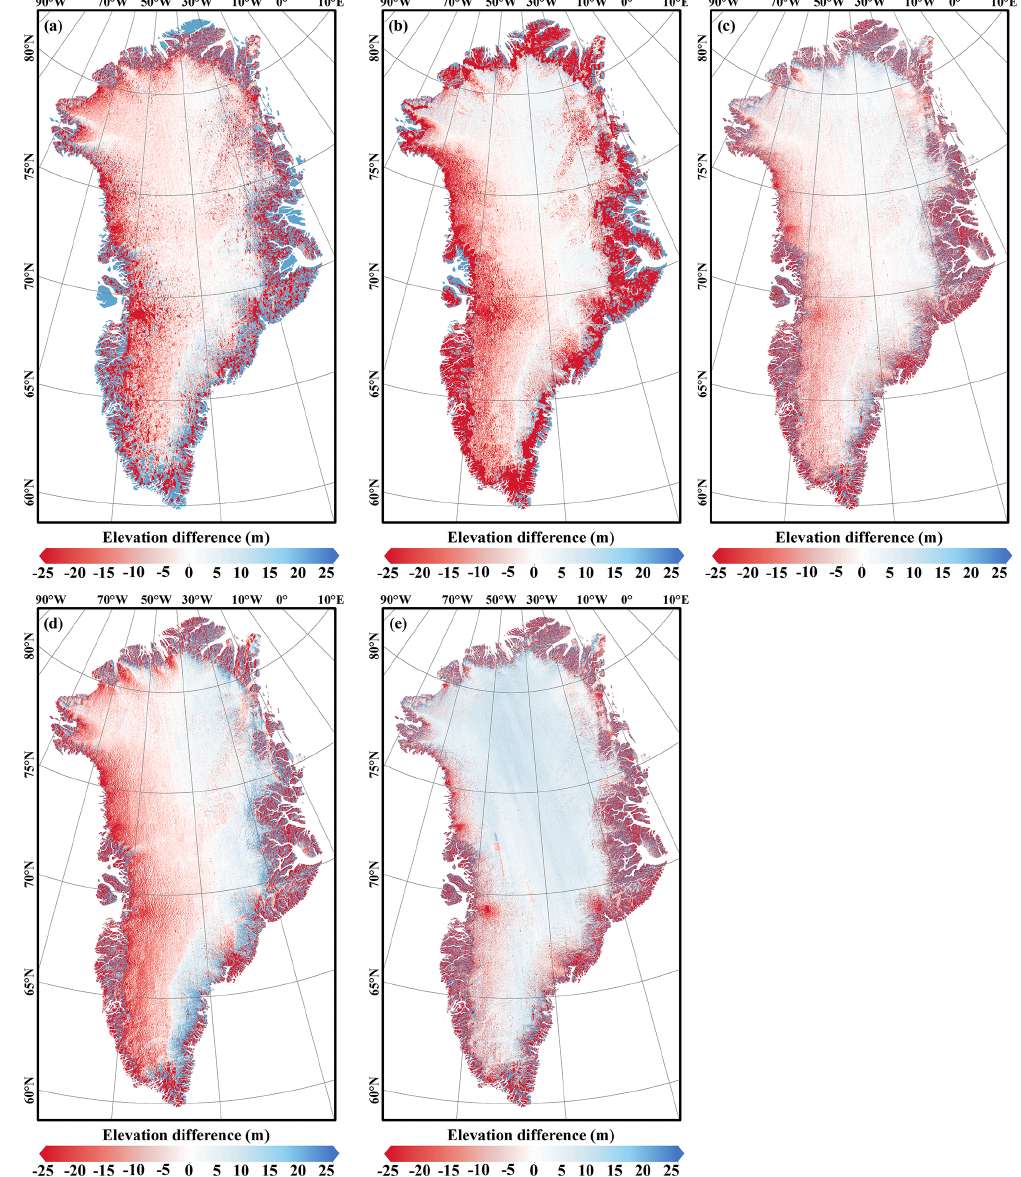
Figure 7. Elevation differences calculated between the new ICESat-2 DEM and the other five published available DEMs: (a) ICESat DEM, (b) CryoSat-2 DEM, (c) 500m ArcticDEM, (d) 1km ArcticDEM, and (e) TanDEM-X. For each picture, the previously published DEM was resampled to 500m, and the difference was calculated as the resampled DEM subtracted from the new ICESat-2